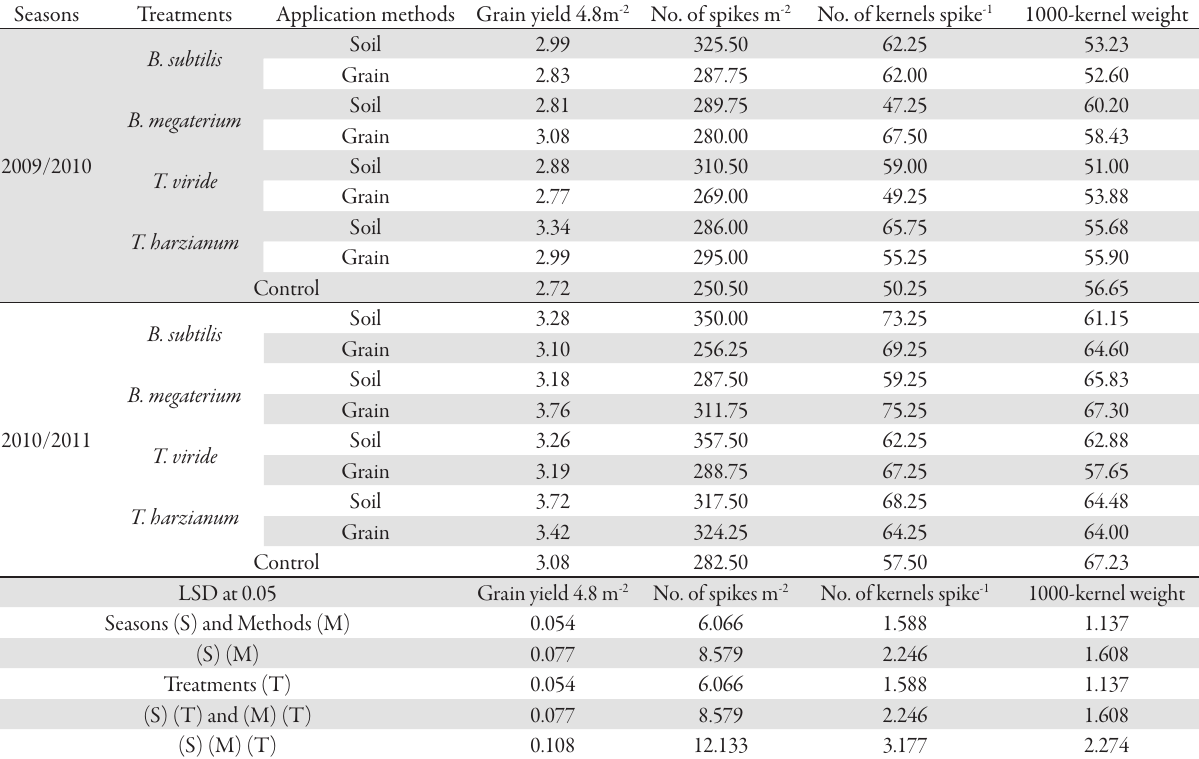
Tab. 8. Effect of bio-control against on grain yield (Kg 4.8 m -2 ), No. of spikes m -2 , kernels spikes -1 and 1000-kernel weight for ‘Bani Suif 5’ durum wheat cultivar in 2009/2010 and 2010/2011 seasons